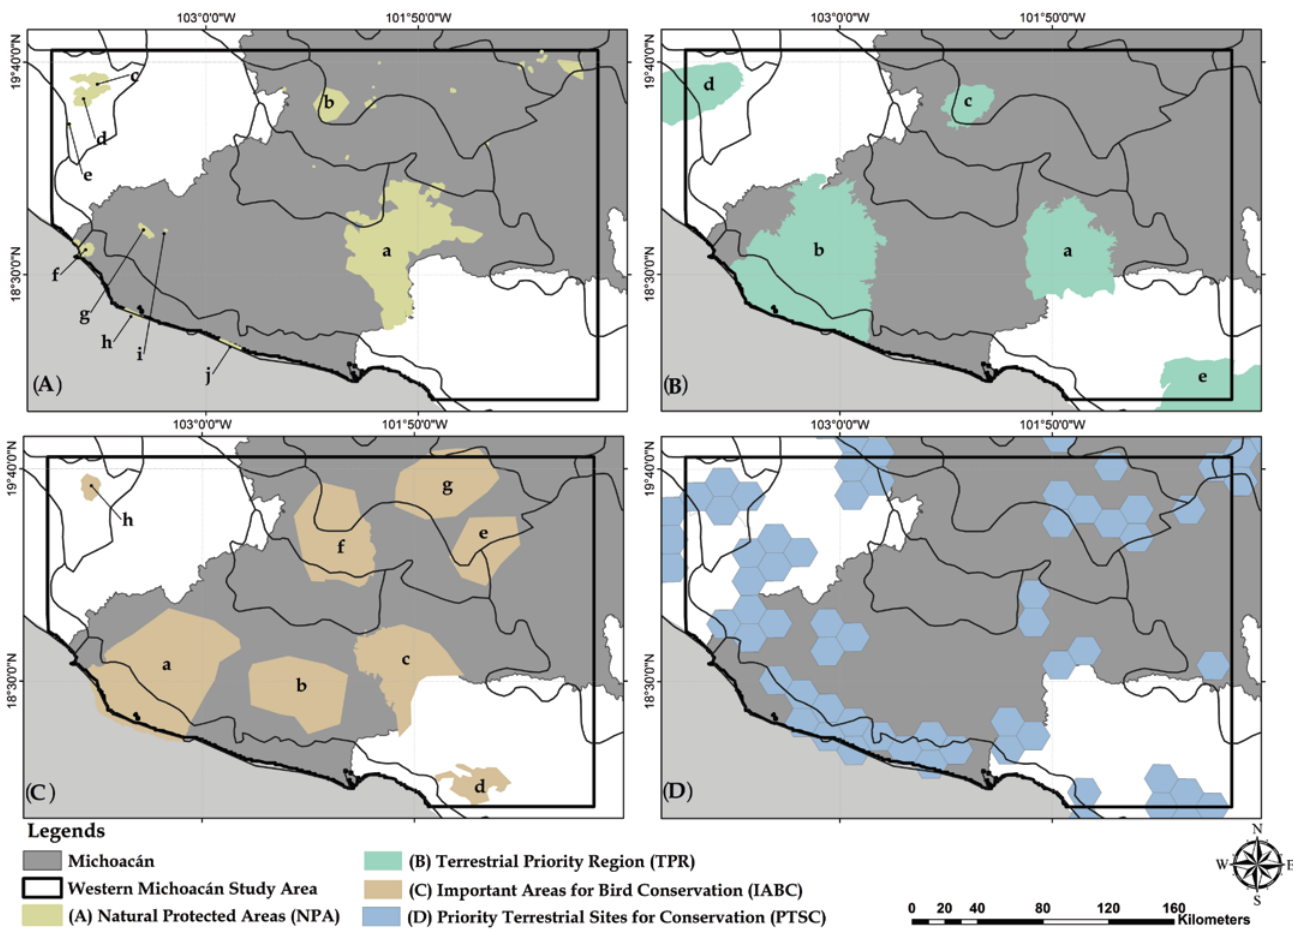
Figure 2. Natural protected areas (NPA) and existing proposed conservation regions and sites in western Michoacán, México. ( A ) NPA: (a) Zicuirán-Infiernillo biosphere reserve (ZIBR), (b) Pico de Tancintaro, (c) Volcán Nevado de Colima, (d) El Jabalí, (e) Las Huertas, (f) Lagunas Costeras y Serranias aledañas de la Costa de Michoacán, (g) El Barrancón de las Guacamayas, (h) Santuario Playa Maruata y Colola, (i) La Chichihua; (j) Santuario Playa Mexiquillo. ( B ) Terrestrial Priority Regions (TPR): (a) Infiernillo, (b) Sierra Coalcomán, (c) Tancíntaro, (d) Manantlán-Volcán de Colima; (e) Sierra Madre del Sur de Guerrero. ( C ) Important Areas for Bird Conservation (IABC): (a) Coalcomán-Pomaro, (b) Tumbiscatio, (c) Cuenca Baja del Balsas, (d) Vallecitos de Zaragoza, (e) Tacambaro, (f) Tancíntaro, (g) Patzcuaro; (h) Nevado de Colima. ( D ) Priority Terrestrial Sites for Biodiversity Conservation (PTSC). Polygons with black outlines are physiographic provinces.